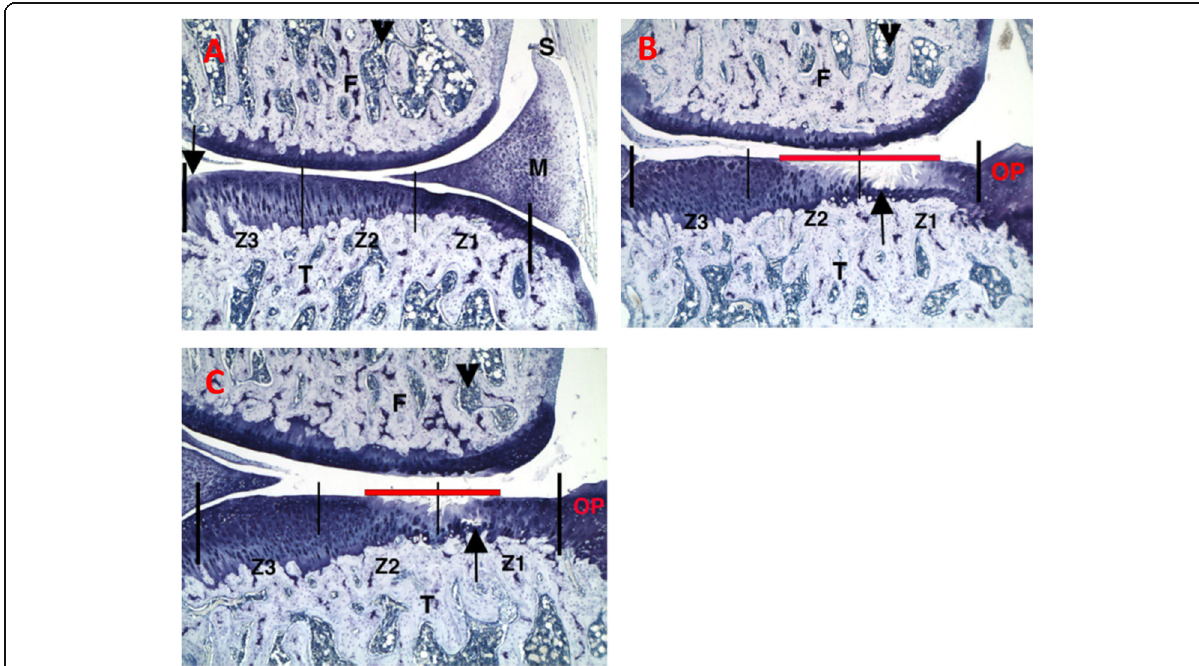
Fig. 1 Representative histopathology photomicrographs stained with toluidine blue. a Sham control group, left knee, medial. b PBS injections at D7, D14, and D21, right knee, medial. c IA-BioHA injections (0.5 mg/rat) at D7, D14, D21, right knee, medial. Vertical bars delineate 2000 μ m of tibial plateau and zones. F - femur; T - tibia; M - meniscus; S - synovium. Arrow identifies a small surface area of minor spontaneous cartilage degeneration in the area not protected by meniscus in zone 3. Arrowhead identifies bone marrow. Red horizontal line identifies extent of collagen degradation. Images acquired at 50x